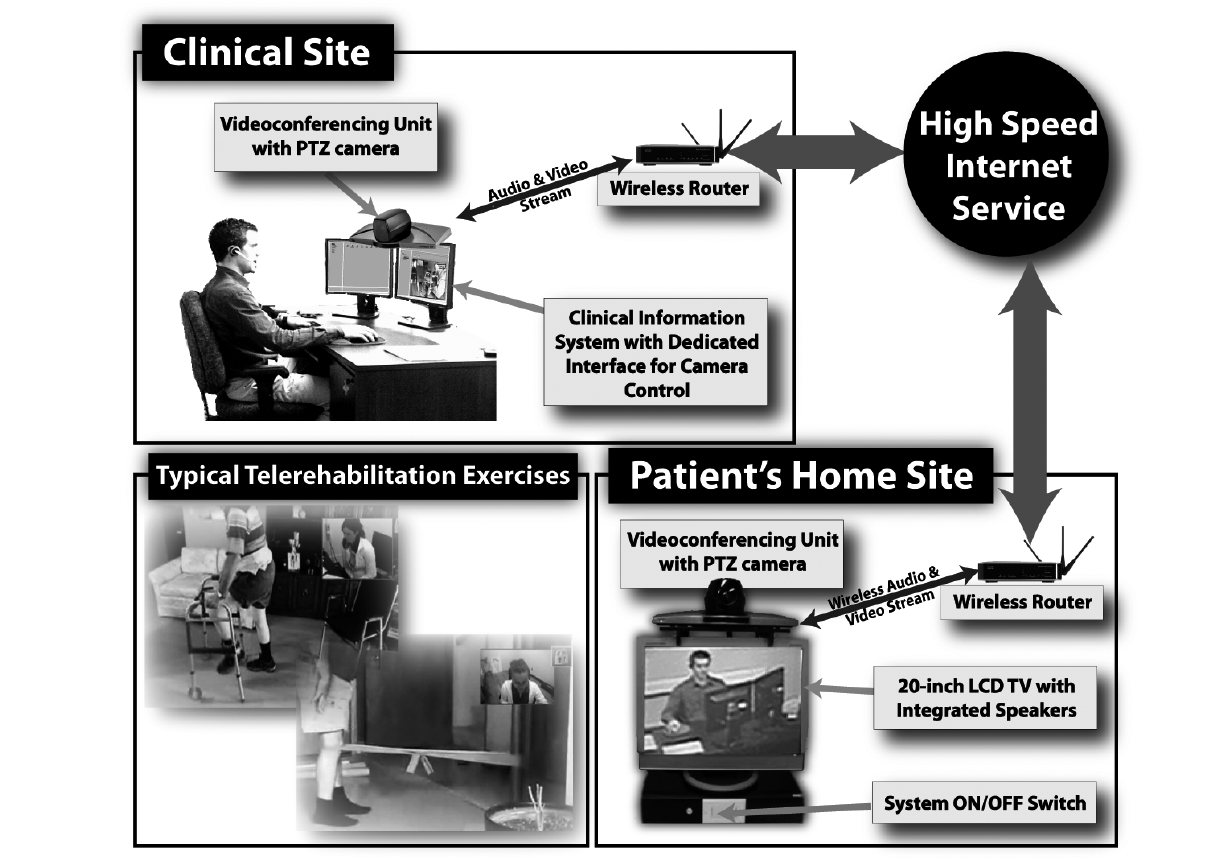
Figure 2. Telerehabilitation